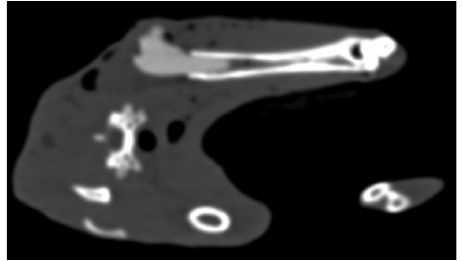
Figure 5 CT map after the implantation of humeral head.